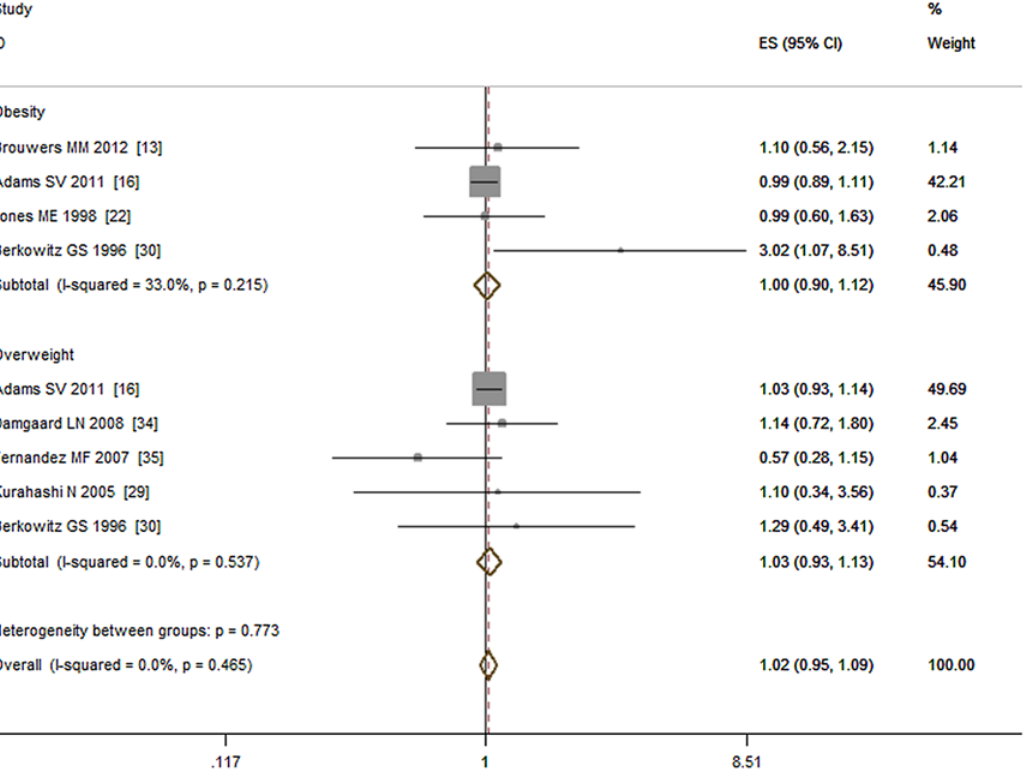
Fig 5. Forest plot for maternal pre-pregnancy BMI and risk of cryptorchidism. Subgroup analysis was conducted by dividing study participants into an obesity group (BMI > 30 kg /m 2 ) and an overweight group (25 kg /m 2 (cid:3) BMI < 30 kg /m 2